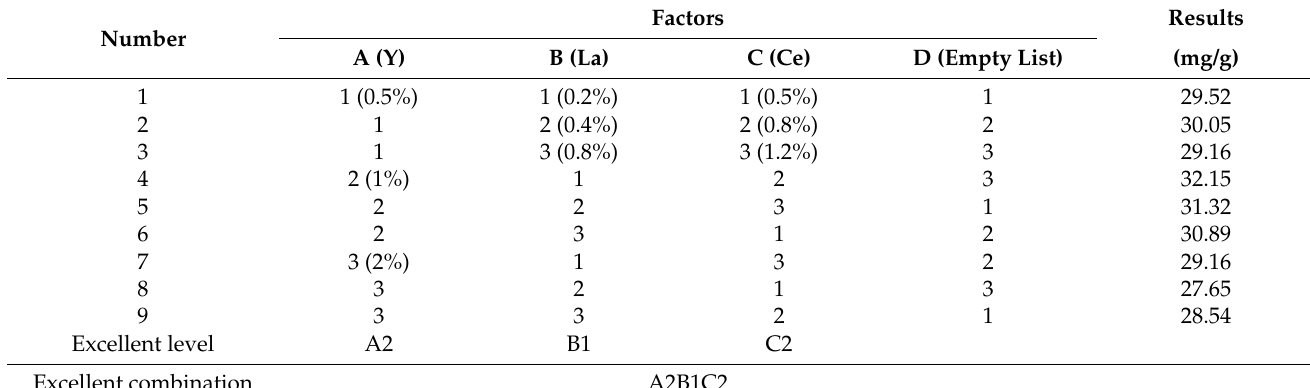
Table 5. Orthogonal Design arrangement of factors.